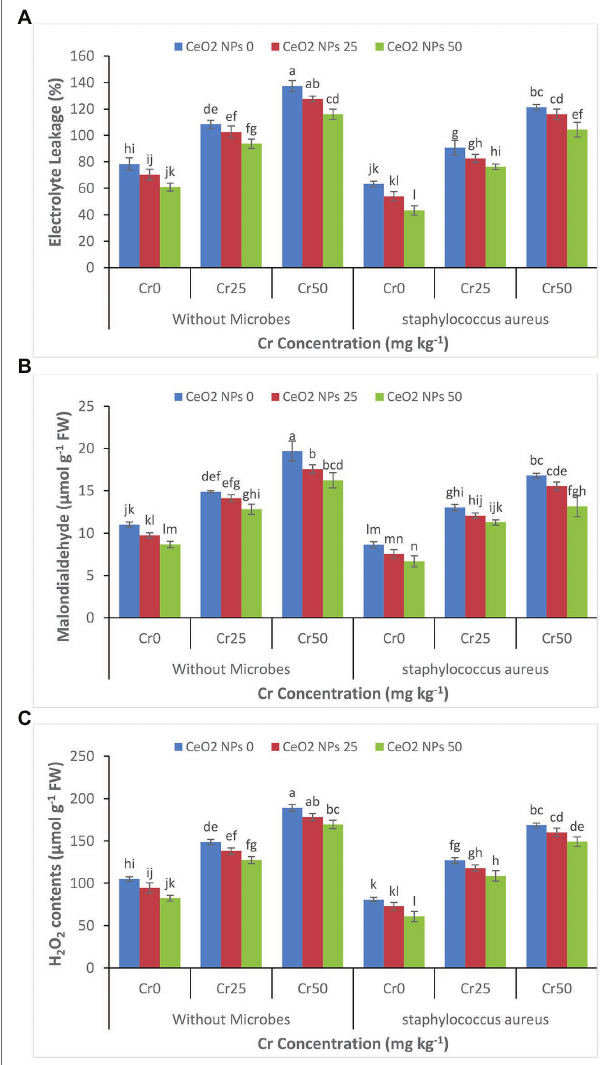
FIGURE 5 | (A–C) : Effect of CeO 2 NPs and Staphylococcus aureus on electrolyte leakage (A) , malondialdehyde contents (B) and H 2 O 2 contents in sunflower plant under Cr stress. The given values are means of three replications with standard deviation. The alphabets represent the significant/ non-significant difference at p ≤